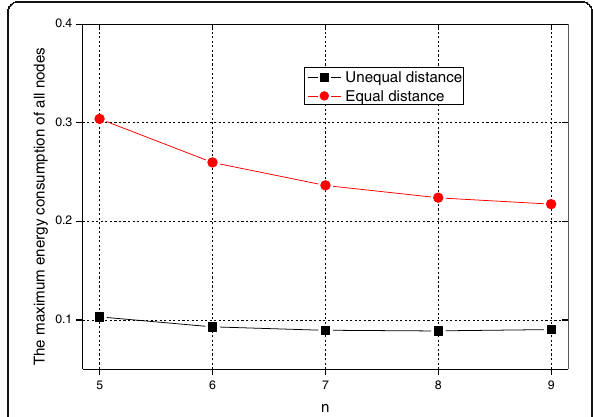
Fig. 34 The maximum energy consumption under UDNP and EDNP